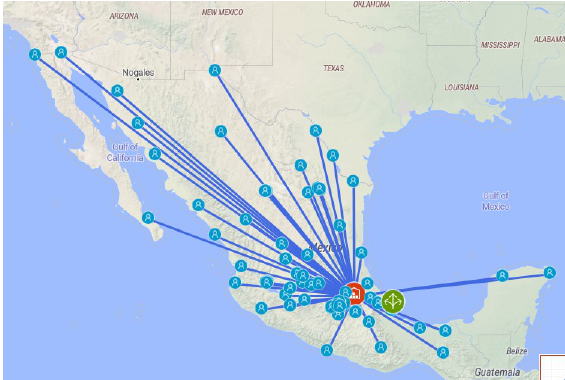
Figure 9. Assignment dealers automotive company